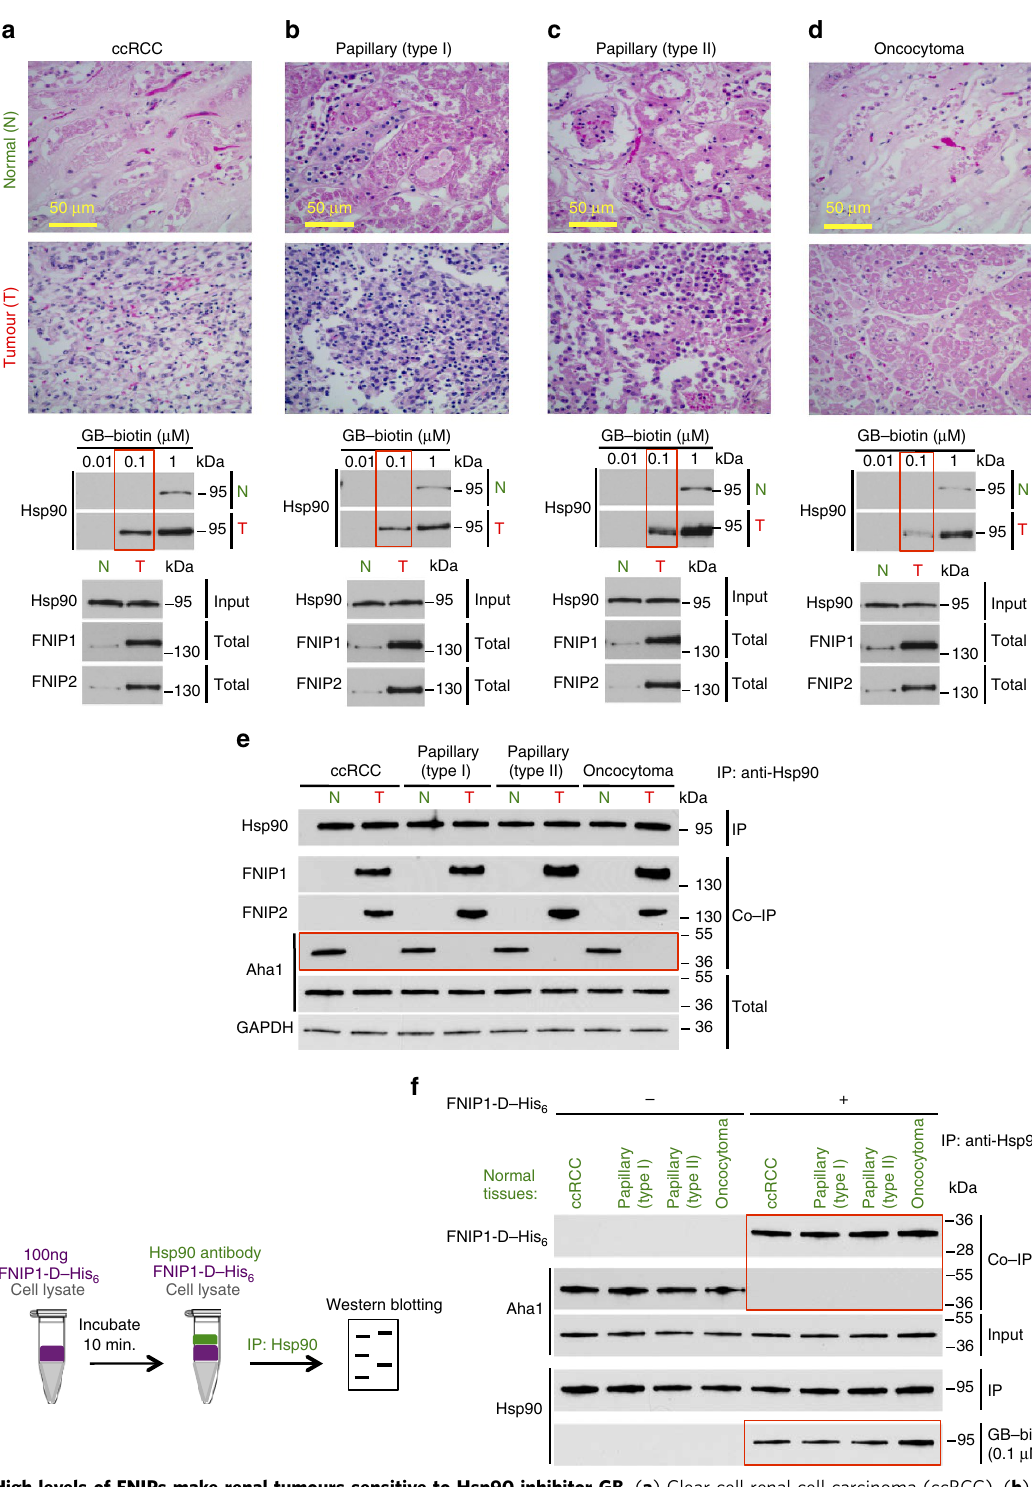
Figure 10 | High levels of FNIPs make renal tumours sensitive to Hsp90 inhibitor GB. ( a ) Clear cell renal cell carcinoma (ccRCC), ( b ) Papillary type I, ( c ) Papillary type II, ( d ) Oncocytoma (Tumours, T) and adjacent normal tissues (Normal, N) were stained with haematoxylin and eosin (H&E). Proteins were also extracted from these tumours and adjacent normal tissues and incubated with indicated amounts of biotinylated GB followed by streptavidin agarose beads. Hsp90 was detected by immunoblotting. Expression of FNIP1 and FNIP2 in these samples was also detected by immunoblotting. ( e ) Hsp90 immunoprecipitated from tumours (T) and adjacent normal tissues (N) in a – d . Co-IP of FNIPs and Aha1 was examined by immunoblotting. ( f ) Lysates from normal tissues in a – d were incubated with or without 100ng of pure FNIP1-D–His 6 for 10min. Hsp90 was immunoprecipitated and co-IP of FNIP1-D–His 6 and Aha1 were shown by